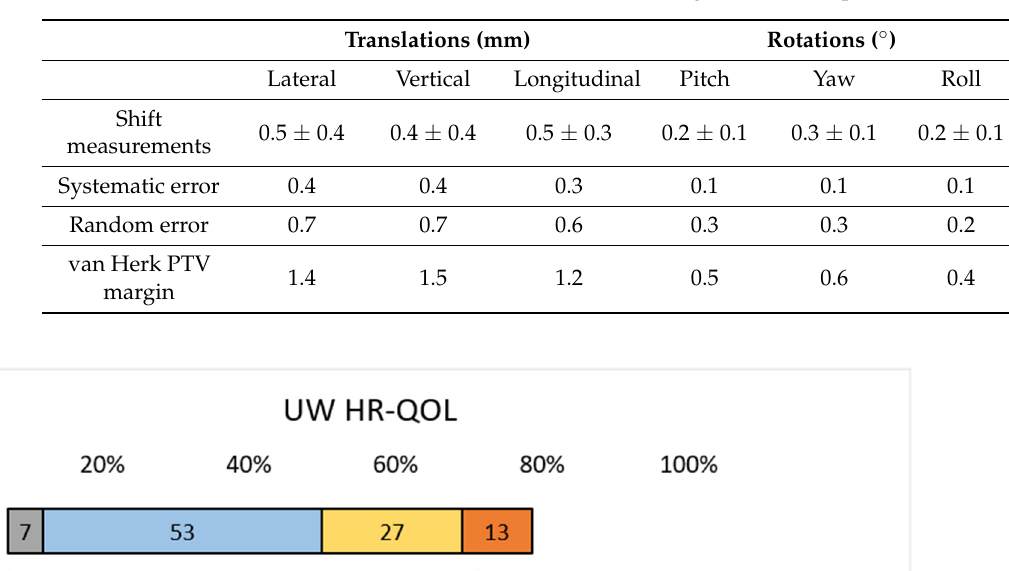
Table A1. Intrafraction motion measurements, error, and van Herk PTV margin calculations. Mean shifts (and standard deviation) calculated for all 5 fractions, averaged over all 15 patients.